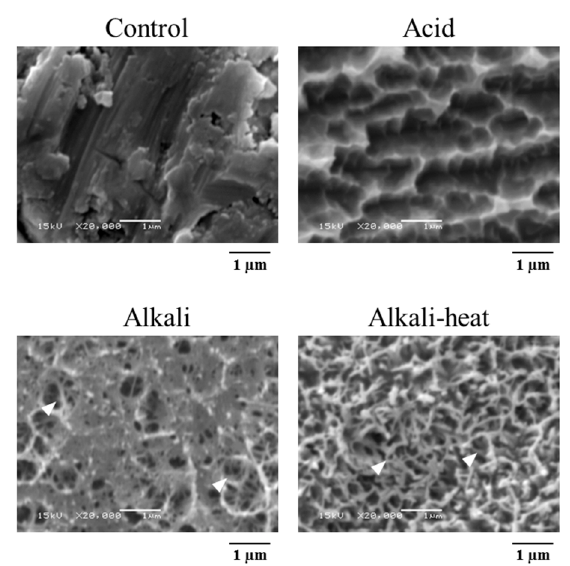
Figure 3. Scanning electron microscopy (SEM) images of the surface-treated Ti disks.